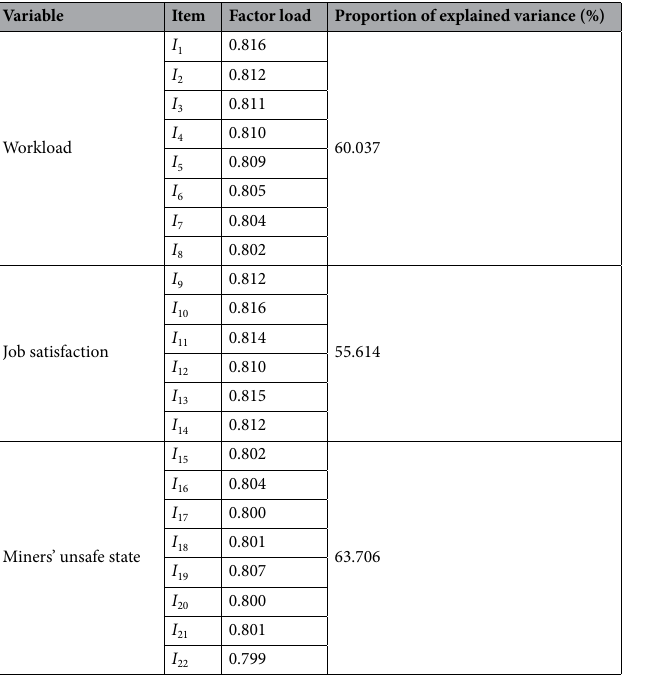
Table 2. Validity test